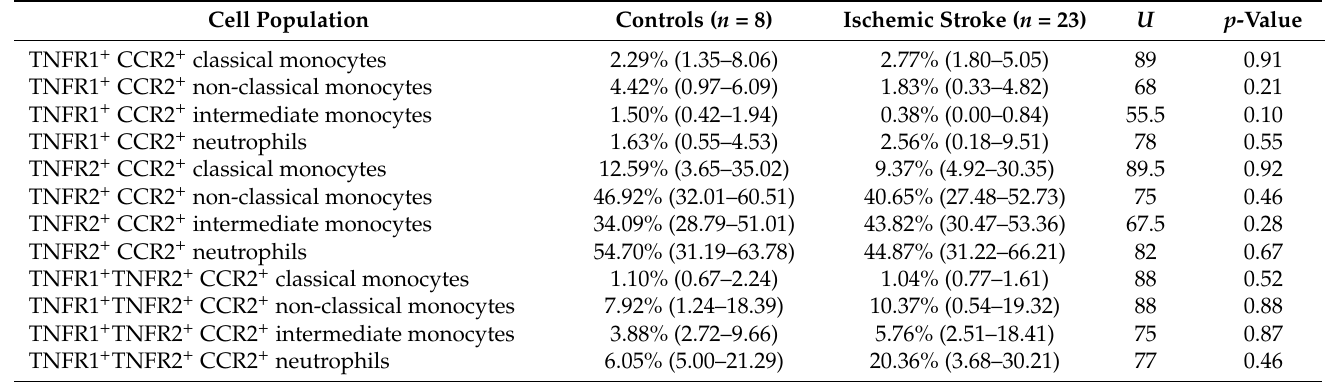
Table 4. TNFR1 and TNFR2 expression on CCR2 + leukocytes. Data are presented as median (25–75% IQR). U , Mann– Whitney U values.